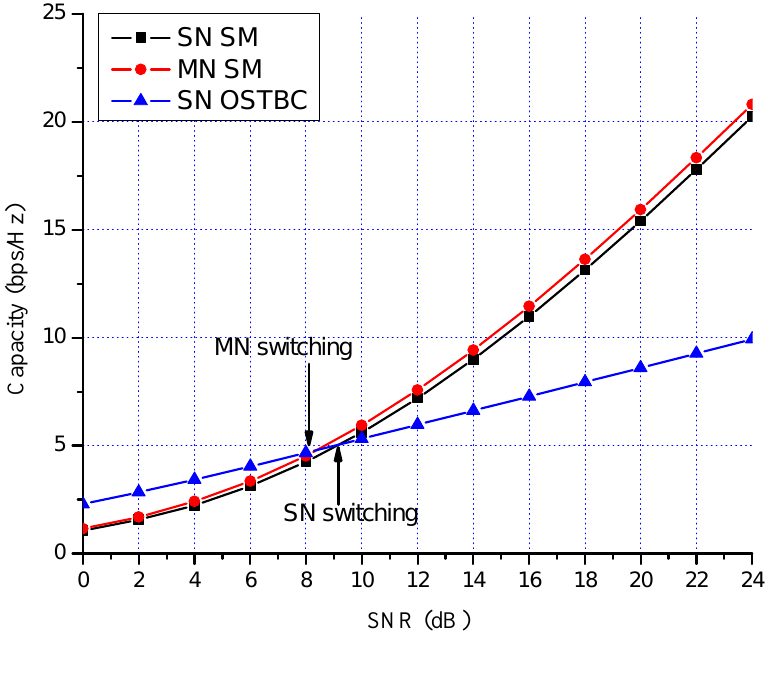
Figure 10. MIMO 4 × 4 capacity with low spatial correlation ( η = 0 . 3 , µ = 0 . 9